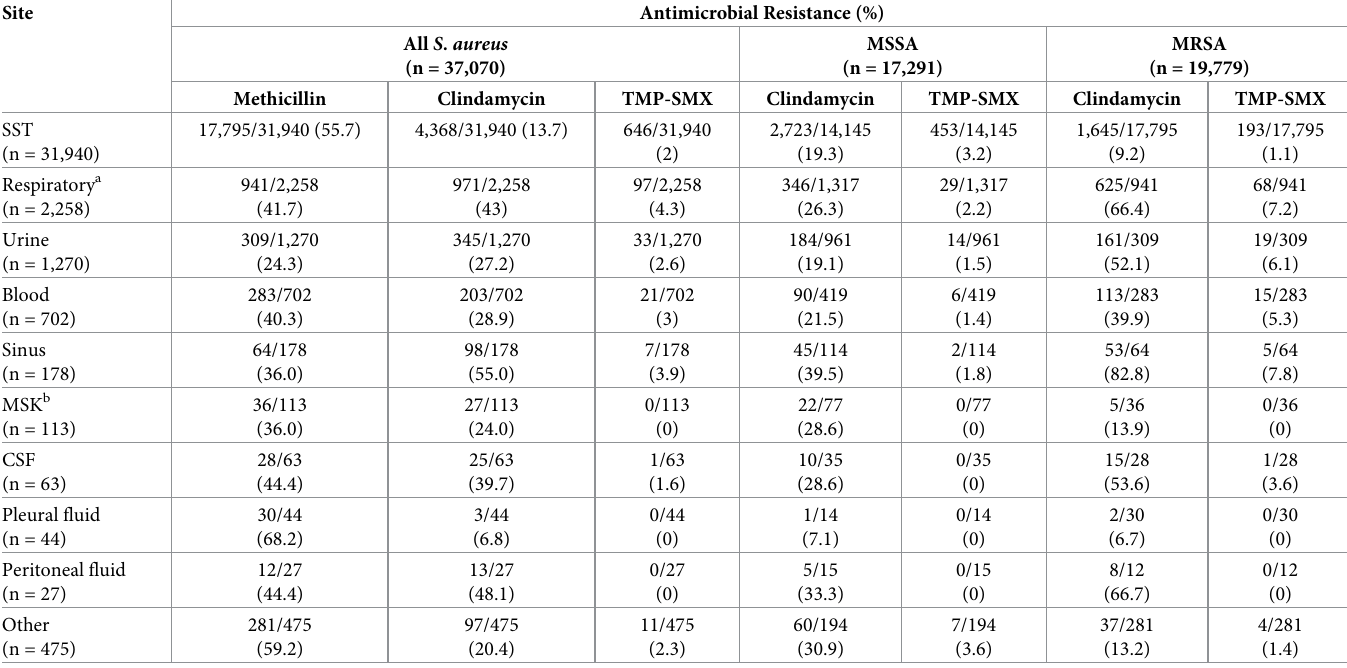
Table 1. Antimicrobial resistance rates to methicillin, clindamycin, and TMP-SMX among S . aureus isolates from NCH (2005–2014) by site of specimen collection.